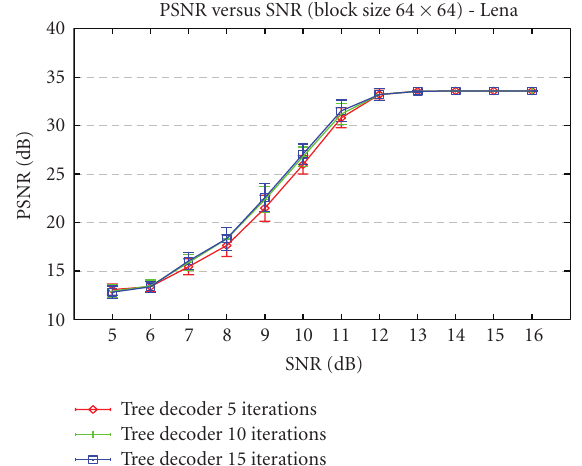
Figure 5: Di ff erent number of iterations (tree decoder).